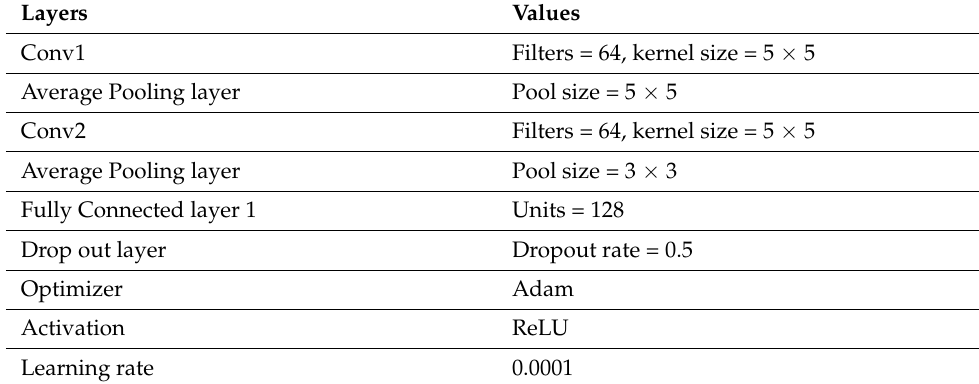
Table 4. CNN model